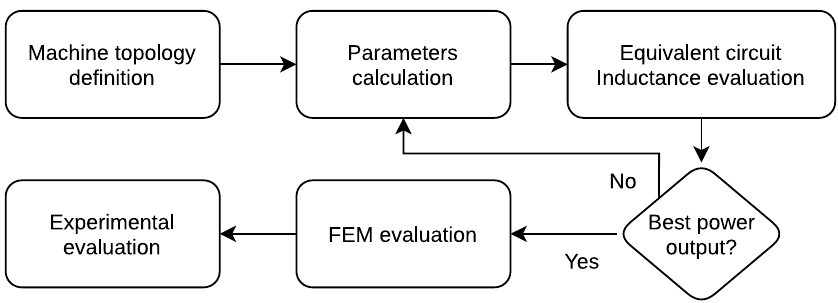
Figure 2. Research work flow